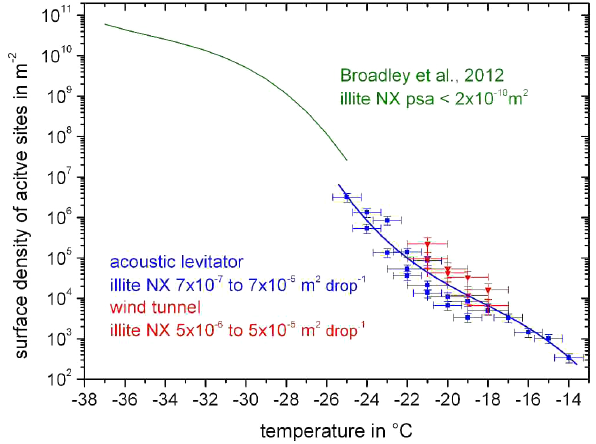
Figure 10. Surface densities of active sites as functions of tempera- ture for illite NX derived from present (shown in blue and red) and previous experiments (shown in green, from Broadley et al.,